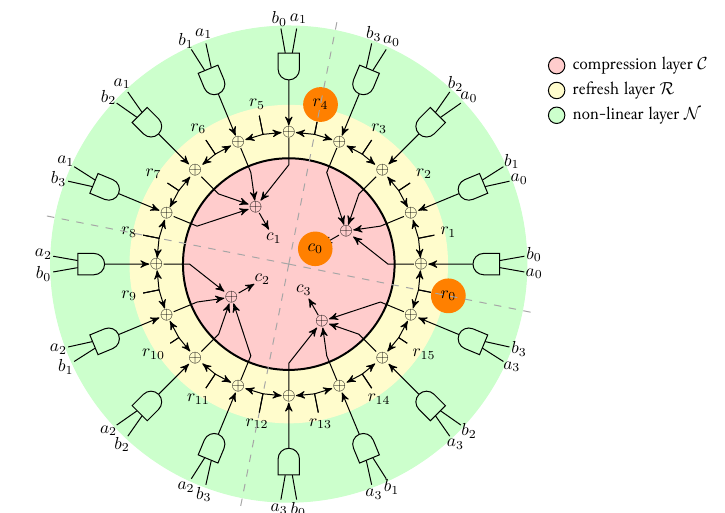
Figure 11: The four-share CMS scheme considered in [MMSS19]. The scheme is decom- posed in three layers, non-linear ( N ), refresh ( R ) and compression ( C ). To preserve output shares from the propagation of glitches, a register (thick line) layer is inserted between compression and refresh. Orange circles correspond to regular probes that break the d -probing